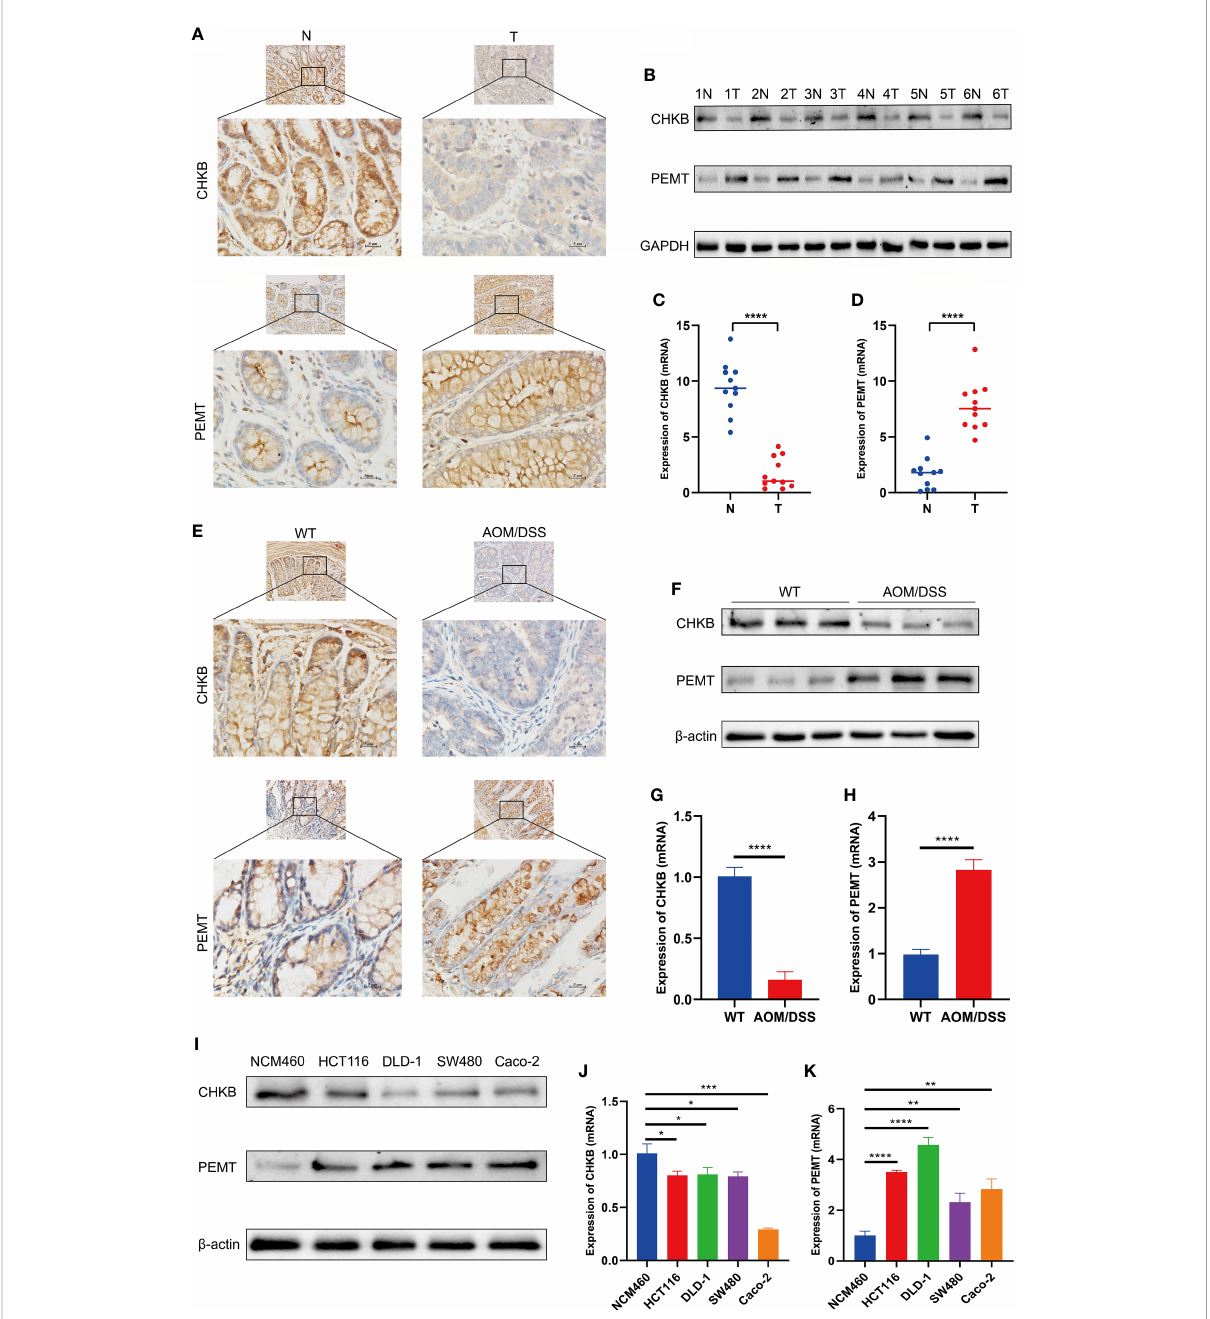
FIGURE 13 Expression of key choline metabolism-related genes in human, animal and cell lines. (A) IHC images of CHKB and PEMT in COAD tissue and paracancerous tissue (magni fi cation ×200 and ×400). Scale bars: 10µm for 200×, 5µm for 400×. N represents paracancerous tissues, and T represents COAD tissues. (B) Protein expression of CHKB and PEMT in six pairs of COAD patients by Western blot. N represents paracancerous tissues, and T represents COAD tissues. (C, D) mRNA expression of CHKB (C) and PEMT (D) in COAD tissues and paracancerous tissues. N represents paracancerous tissues, and T represents COAD tissues. **** p < 0.0001. (E) IHC images of CHKB and PEMT in wild-type (WT) and AOM/DSS mice. WT represents control mice, and AOM/DSS represents COAD mouse model. (F) Protein expression of CHKB and PEMT in WT and AOM/DSS mouse by Western blot. WT represents control mice, and AOM/DSS represents COAD mouse model. (G, H) mRNA expression of CHKB (G) and PEMT (H) in WT and AOM/DSS mouse. WT represents control mice, and AOM/DSS represents COAD mouse model. **** p < 0.0001. (I) Protein expression of CHKB and PEMT in human normal intestinal epithelial cell NCM460 and human COAD cell lines (Caco-2, SW480, DLD-1, HCT 116) by Western blot. (J, K) mRNA expression of CHKB (J) and PEMT (K) in human normal intestinal epithelial cell NCM460 and human COAD cell lines (Caco-2, SW480, DLD-1, HCT 116). *p< 0.05 ; **p< 0.01 ; ***p< 0.001 ; ****p<